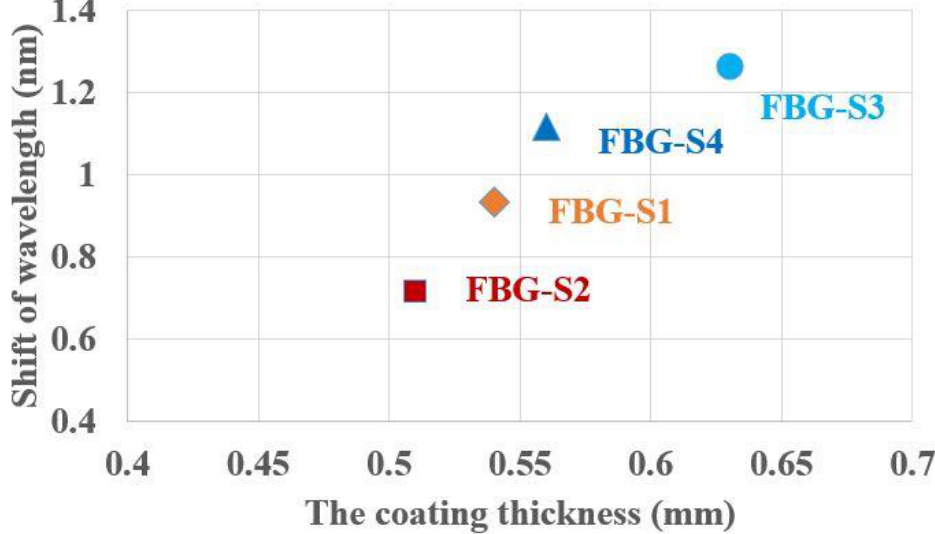
Figure 5. The relationship between the shift of the Bragg wavelength and the coating thickness (the coating thicknesses of the UV-curable resin for FBG-S1, FBG-S2, FBG-S3 and FBG-S4 are 0.54 mm, 0.51 mm, 0.63 mm and 0.56 mm, respectively).